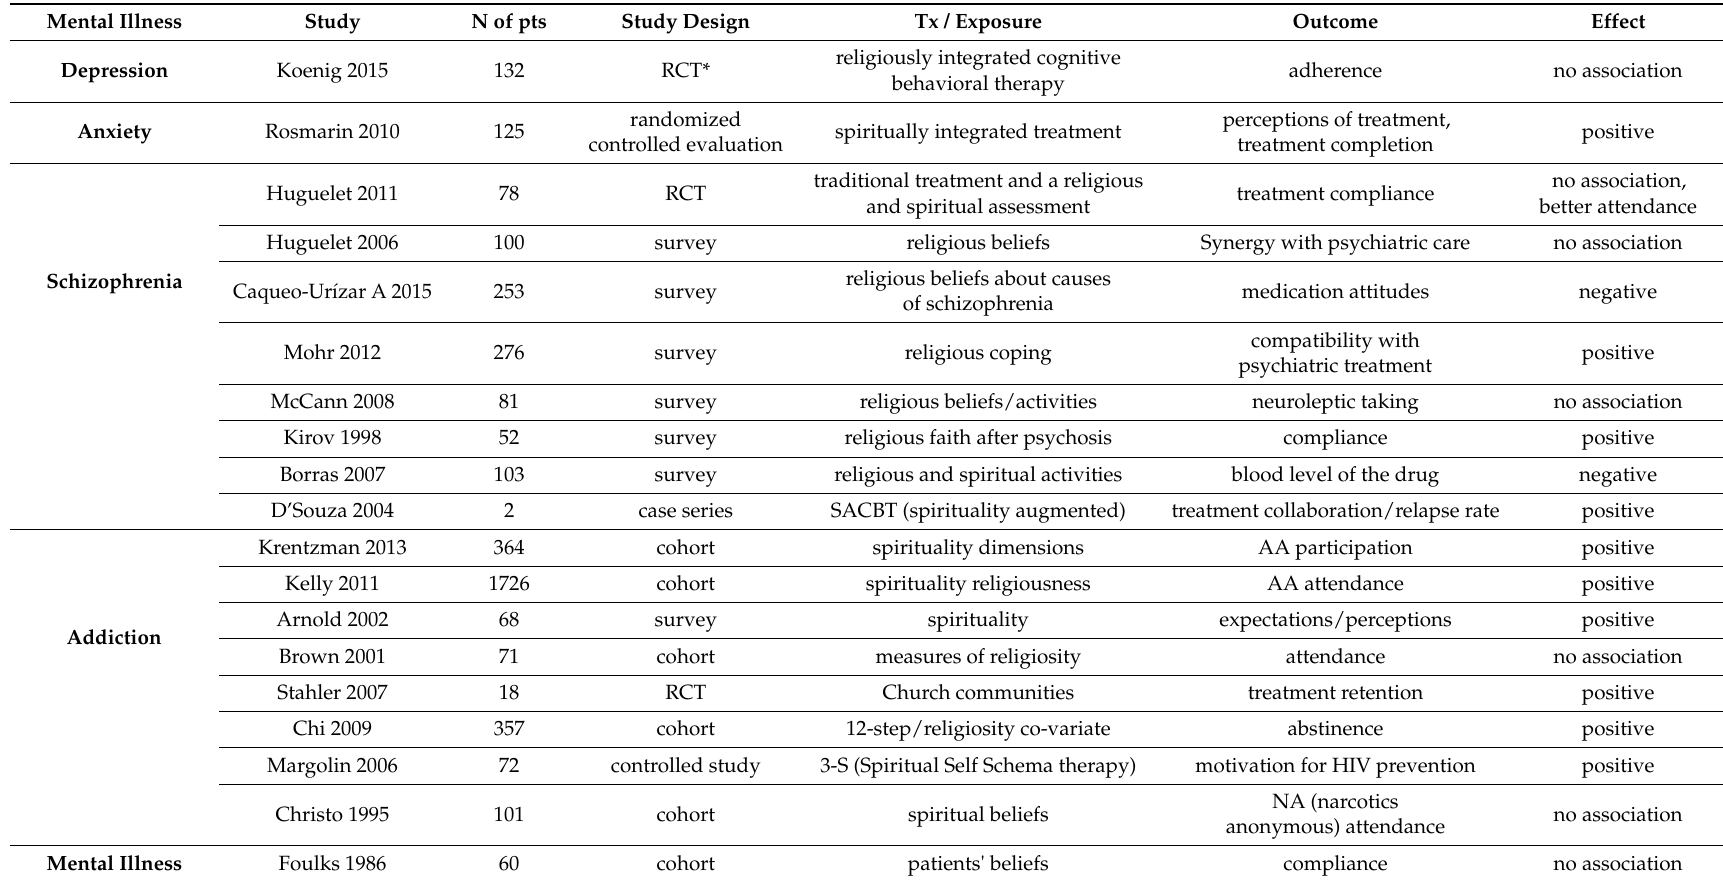
Table 1. Characteristics of studies included in the